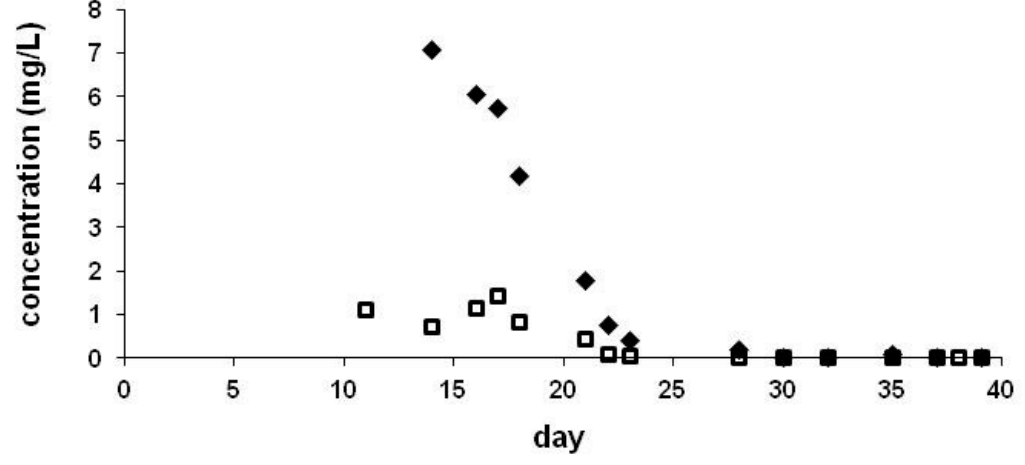
Figure 3. Concentration of CLO ( ♦ ) and thiamethoxam (TMX) ( □ ) in the guttation liquid collected from crown cup. Maize seeds were coated by 0.605 mg/seed TMX or 1.217 mg/seed CLO, experiments were performed outdoors in pots.